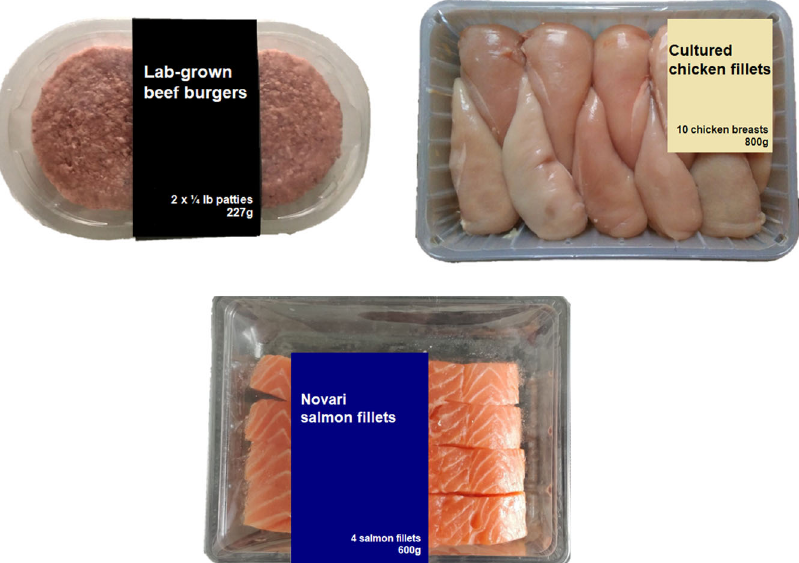
Fig. 12 Samples of the images used for beef, chicken, and salmon with different labels. Image created by Christopher Bryant utilizing images from world.openfacts.org (Creative Commons licenses, via Google Images). These images were shown with varied labels according to experimental condition.